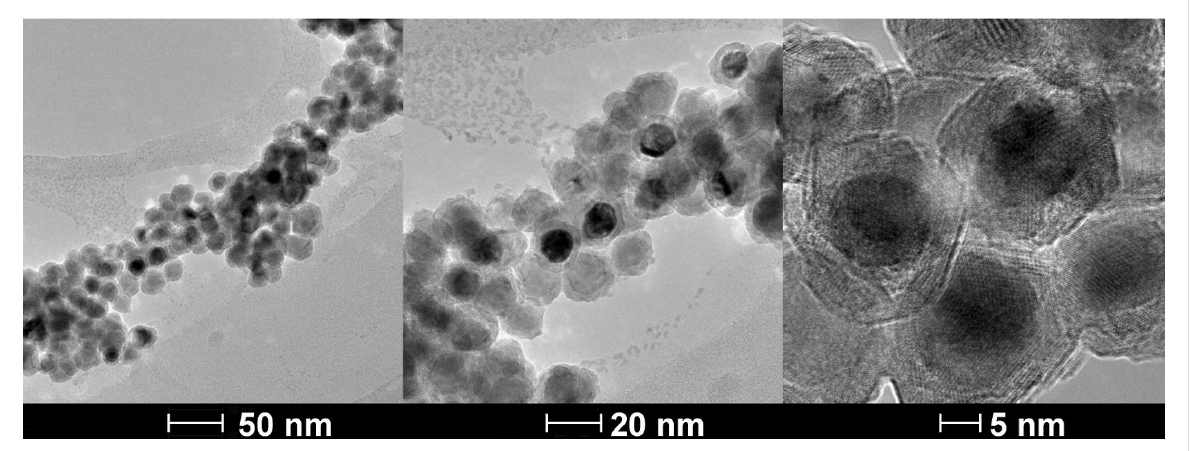
Figure 2: TEM and HRTEM of Fe/Fe 3 O 4 nanoparticles prepared by thermal decomposition of Fe(CO) 5 in the presence of oleylamine and HDA·HCl.